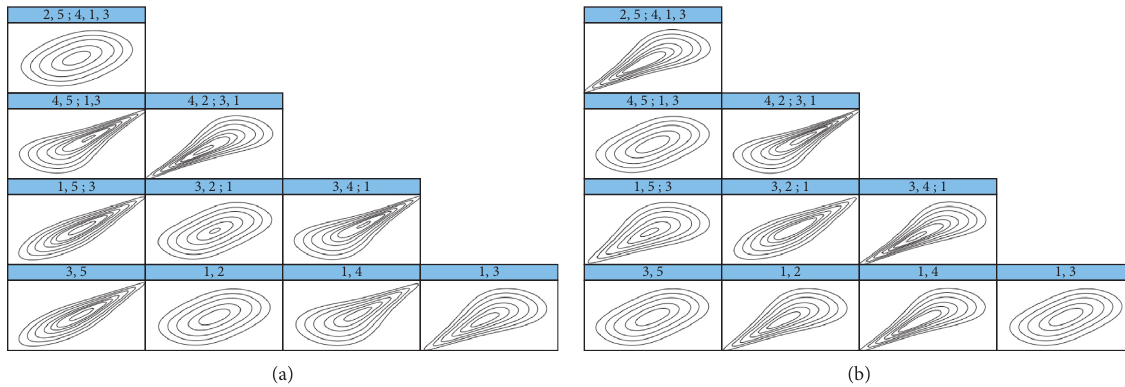
Figure 3: Contour plot of the R-vine model. (a) Contour plot of the first component. (b) Contour plot of the second